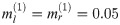
Chirality provides a fitness advantage in competition, but not in overall growth.The first two panels show that a non-chiral (A) and a chiral strain (B) expand with the same velocity. To facilitate this comparison, we started the simulations with a linear instead of a circular front. Panel (C) demonstrates the chiral strain displaces the non-chiral strain when they compete within the same colony: A small initial population of the right-handed strain (shown in red) expands over time and eventually takes over. Because the simulations respect the mirror symmetry, the results were the same irrespective of whether the chirality was due to a left-handed or a right-handed bias in motility. Note that the fate of a strain is not determined solely by its expansion velocity because the colonies expand as pushed waves [47, 49–51]. The expansion velocity of a pushed wave depends not only on the growth and migration rates at the leading edge, but also on the non-linear population dynamics within the wave front. As a result, the outcome of the competition is affected by how each of the strains responds to the presence of the other strain. In our simulations, expansions are pushed because of the density-dependent motility; see Methods and SI. Here, m0 = ms = mb = md = 0, g = 0.1, N = 200 for both strains. ml(1)=mr(1)=0.05, ml(2)=0.01, mr(2)=0.09 on a lattice of 600x3300 sites. All distances were measured in 100 units where Δx = Δy = 1 unit.